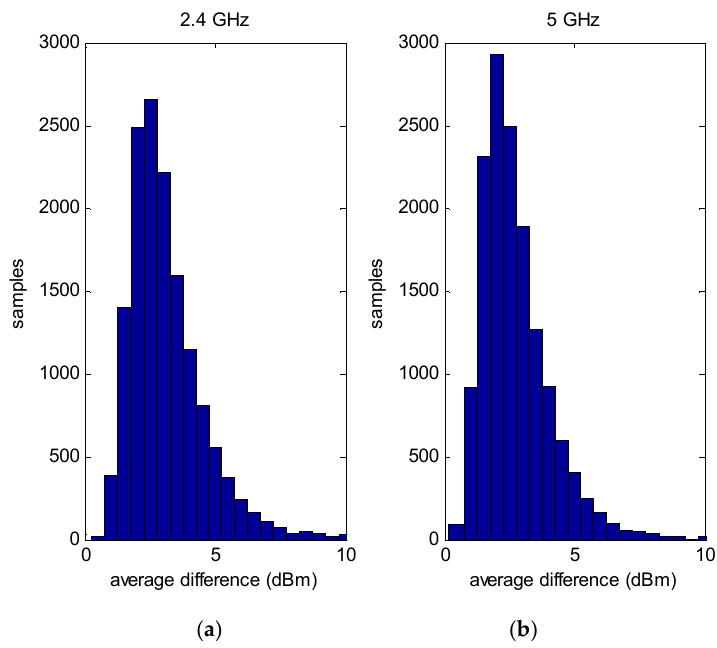
Figure 11. Average absolute difference of the RSS of a sampling point relative to neighbors within a 0.8 m radius. ( a ) 2.4 GHz Wi-Fi data; ( b ) 5 GHz Wi-Fi data.